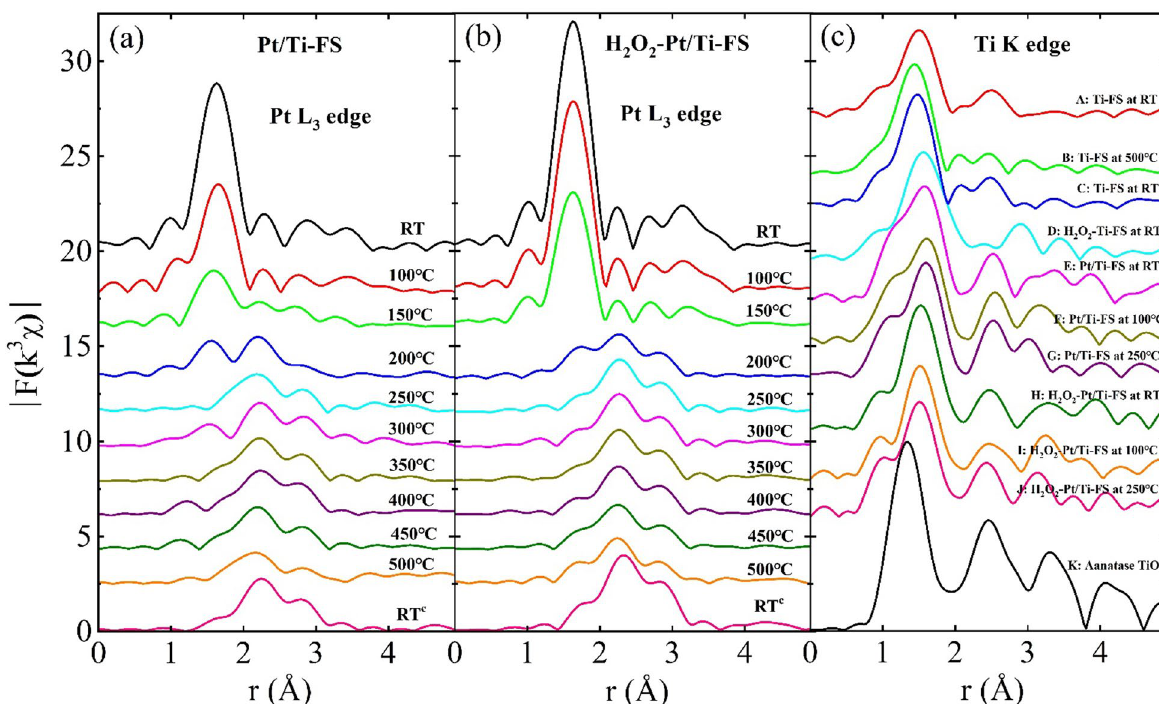
Figure 4. Magnitude of FT-EXAFS (|k 3 χ |) as functions of the distance from a Pt atom of ( a ) Pt/Ti–FS and ( b